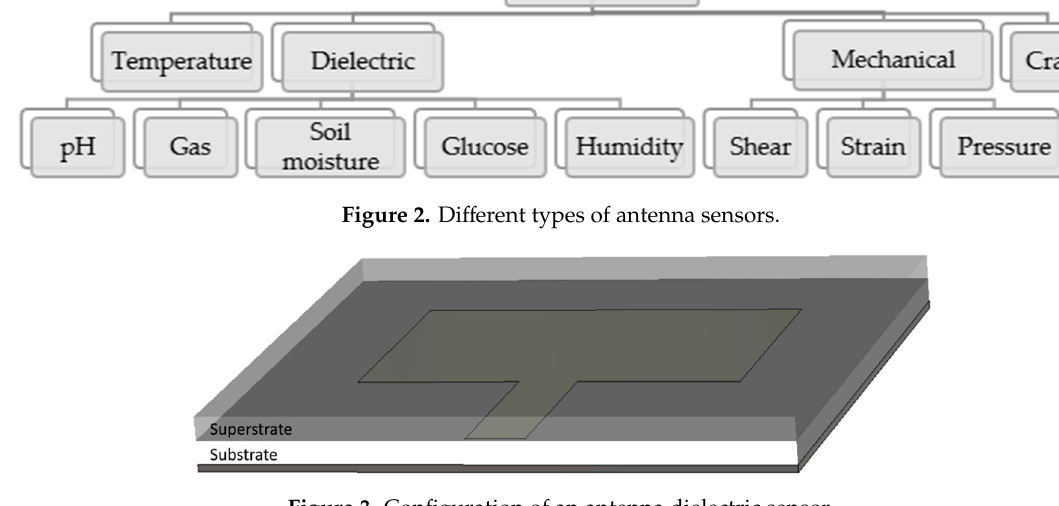
Figure 3. Configuration of an antenna dielectric sensor. Table 1. Summary of previously reported works on antenna dielectric sensors.